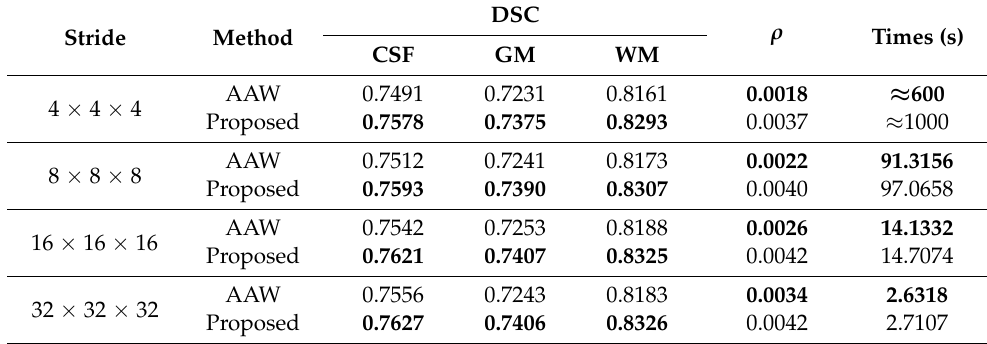
Table 3. Registration results of different strides and the best results are shown in bold.